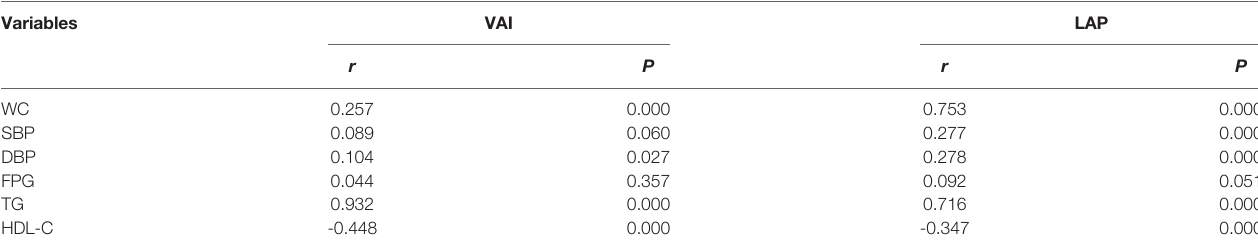
TABLE 2 | Relationship between VAI, LAP and metabolic syndrome.